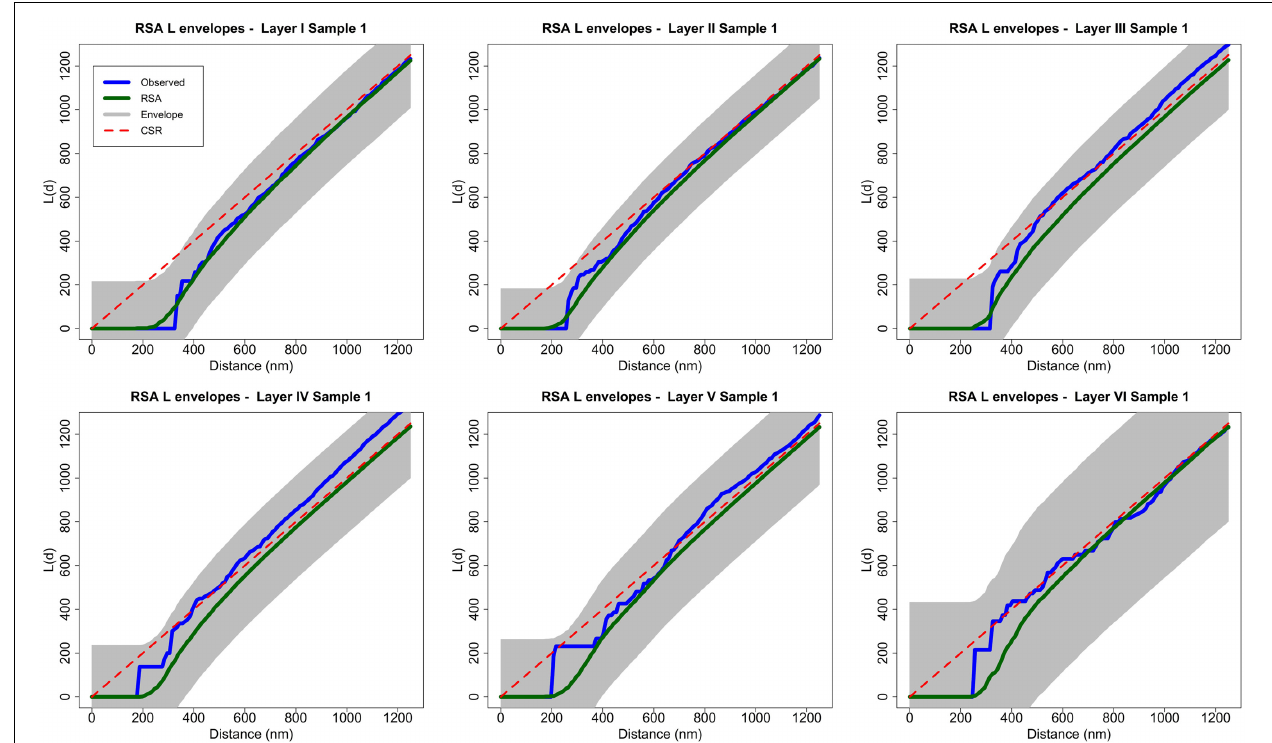
FIGURE 3 | Analysis of spatial patterns using global envelopes (sample 1 for each layer of the somatosensory cortex). The L functions of the experimentally observed samples are shown in blue, and the averages of 99 RSA simulations are shown in green. The shaded area represents the envelopes of values calculated from a separate set of 99 RSA